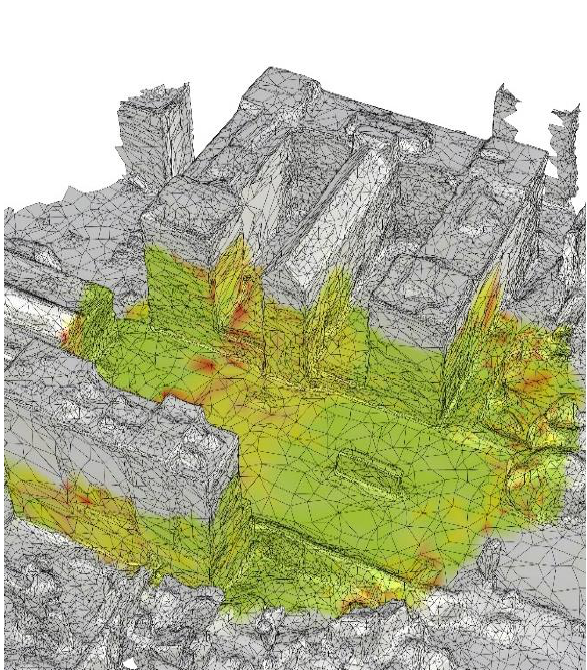
Figure 4 - The mesh built from the photo-modeling of Google Earth images with the RGB